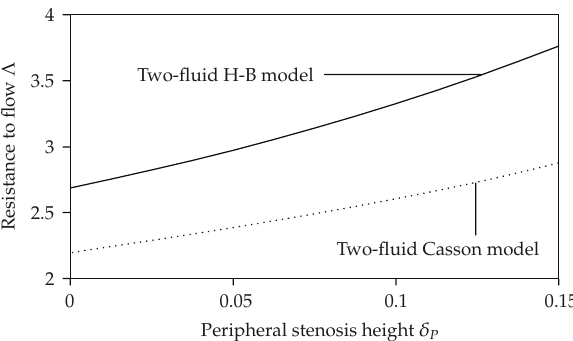
Figure 7: Variation of resistance to flow with peripheral layer stenosis height of the two-fluid Casson and two-fluid Herschel-Bulkley models.